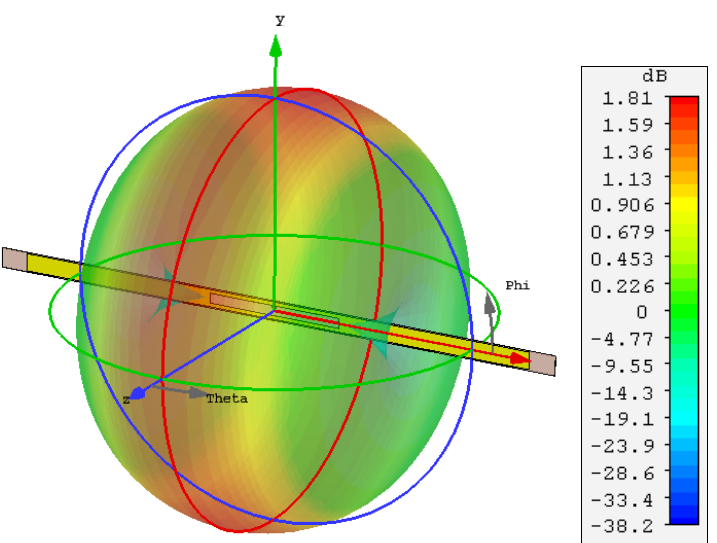
Figure 10. Simulated 3D far-field gain plot of the dipole antenna at 915 MHz, showing a peak gain of 1.81